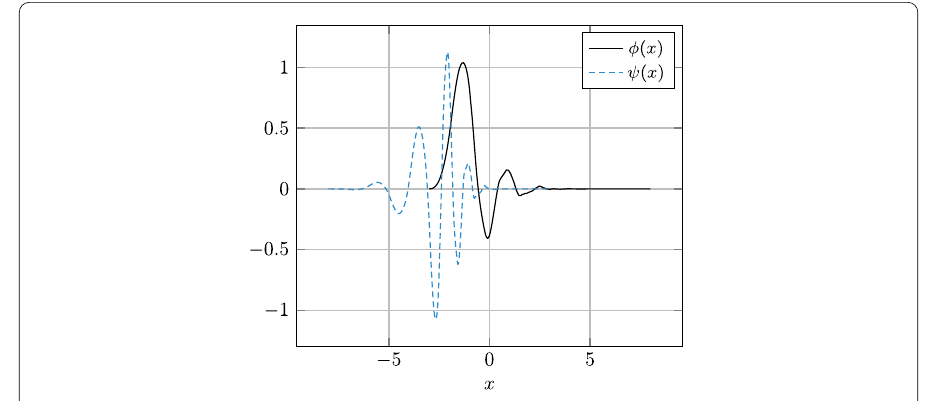
Figure 2 Scaling function φ ( x ) (black and solid) and wavelet ψ ( x ) (blue and dashed) of DB- N kind with N = 6